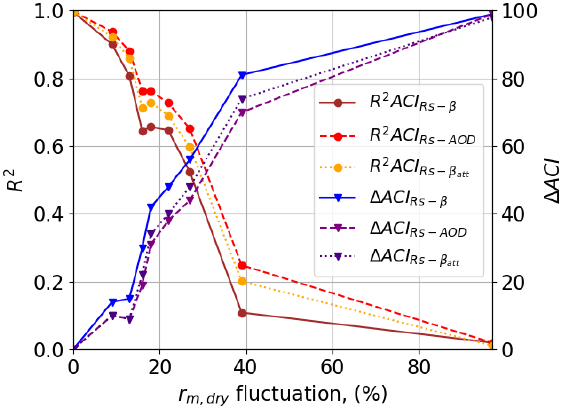
Figure A4. R 2 (left axis) and ∆ ACI (right axis) with Respect to the r m , dry Uncertainty.